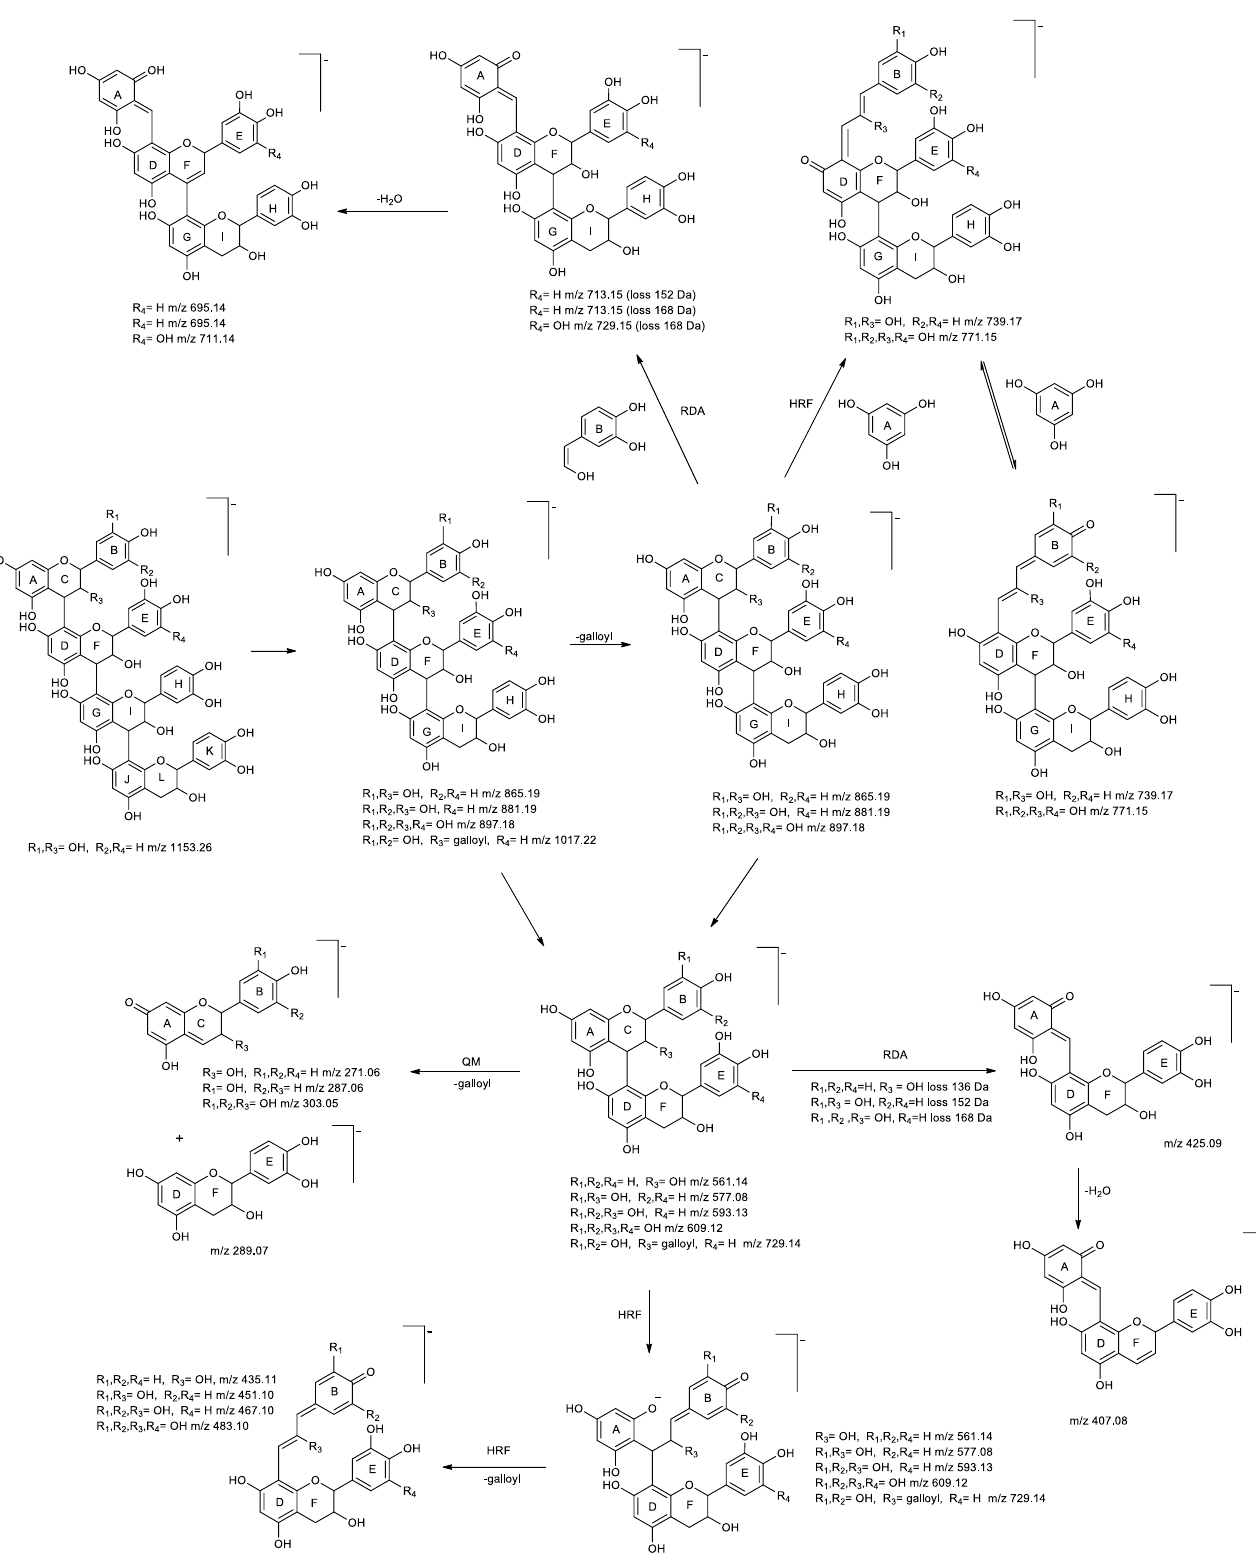
with the pseudomolecular ions at m / z 593.1291 and m / z 593.1314. Both isomers exhibited similar fragmentation pattern. The fragment at m / z 441.08 was an indication of